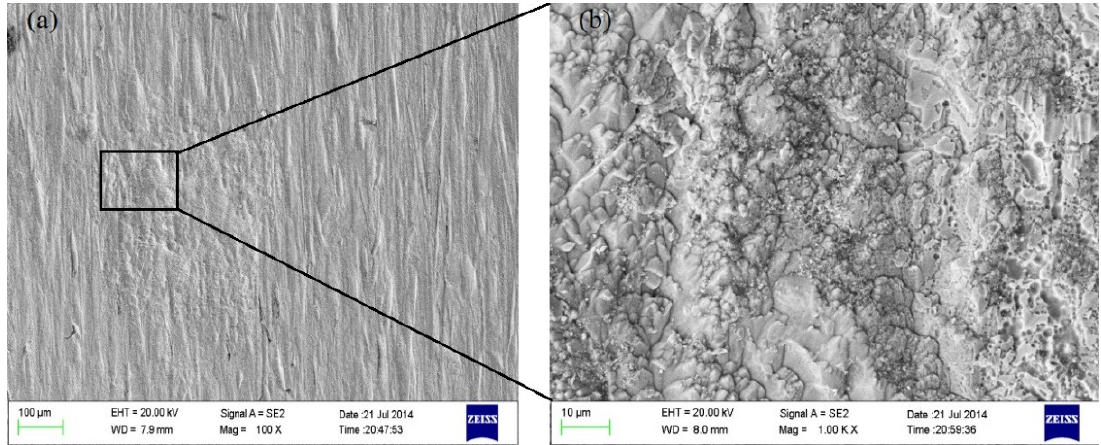
Figure 1. The surface morphology by SEM after 1.5 years exposure: ( a ) 100×; ( b ) 1000×.